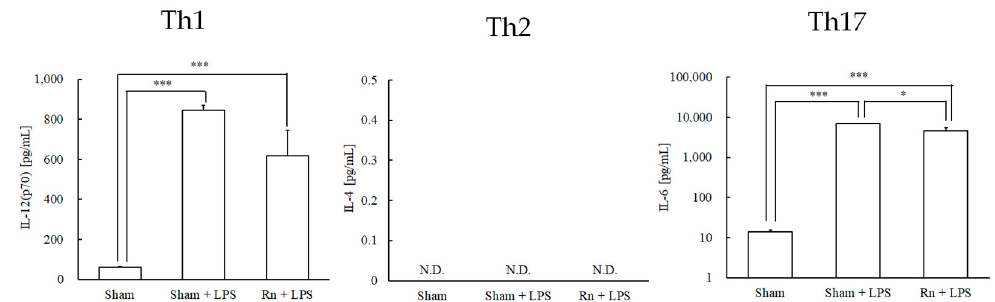
Figure 1. Effects of radon (Rn) inhalation on lipopolysaccharide (LPS)-induced T cell differentiation- inducing cytokines in serum. The results are presented as the mean ± standard error of the mean (SEM). N = 7; all experiments were conducted once; * p < 0.05, *** p < 0.001; IL, interleukin; N.D., not detected; sham, mouse group without any treatment; sham + LPS, mouse group that inhaled sham followed by LPS (1 mg/kg body weight); Rn + LPS, mouse group that inhaled radon (2000 Bq/m 3 ) followed by LPS (1 mg/kg body